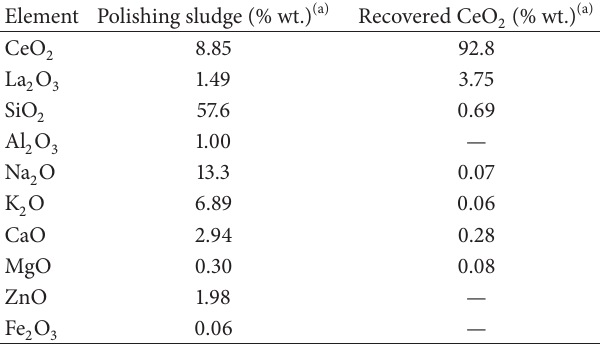
Table 1: Elemental composition of waste polishing sludge and recovered CeO 2 (expressed as respective